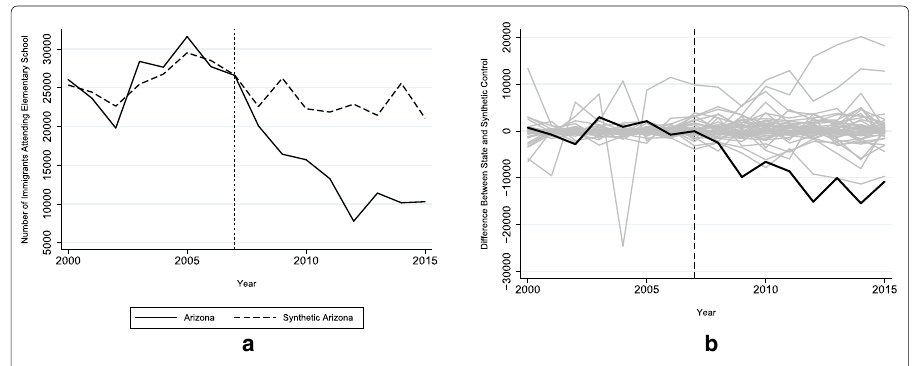
Fig. 1 LAWA and number of immigrants in elementary school. a Number of immigrants. b Permutation test school students in Arizona before 2007, this decline represents a reduction of 35% of foreign-born elementary school students in pre-LAWA Arizona.